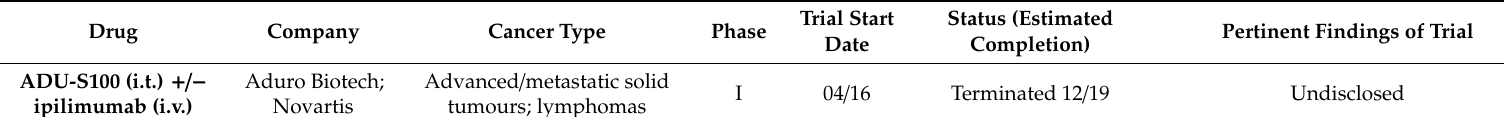
Table 2. STING Agonists in Clinical